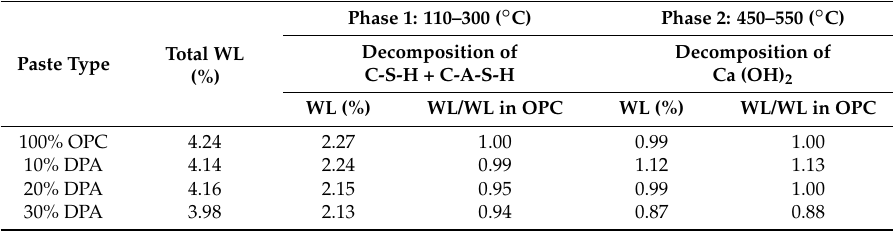
Table 3. Weight loss in paste mixtures at the age of 360 days.